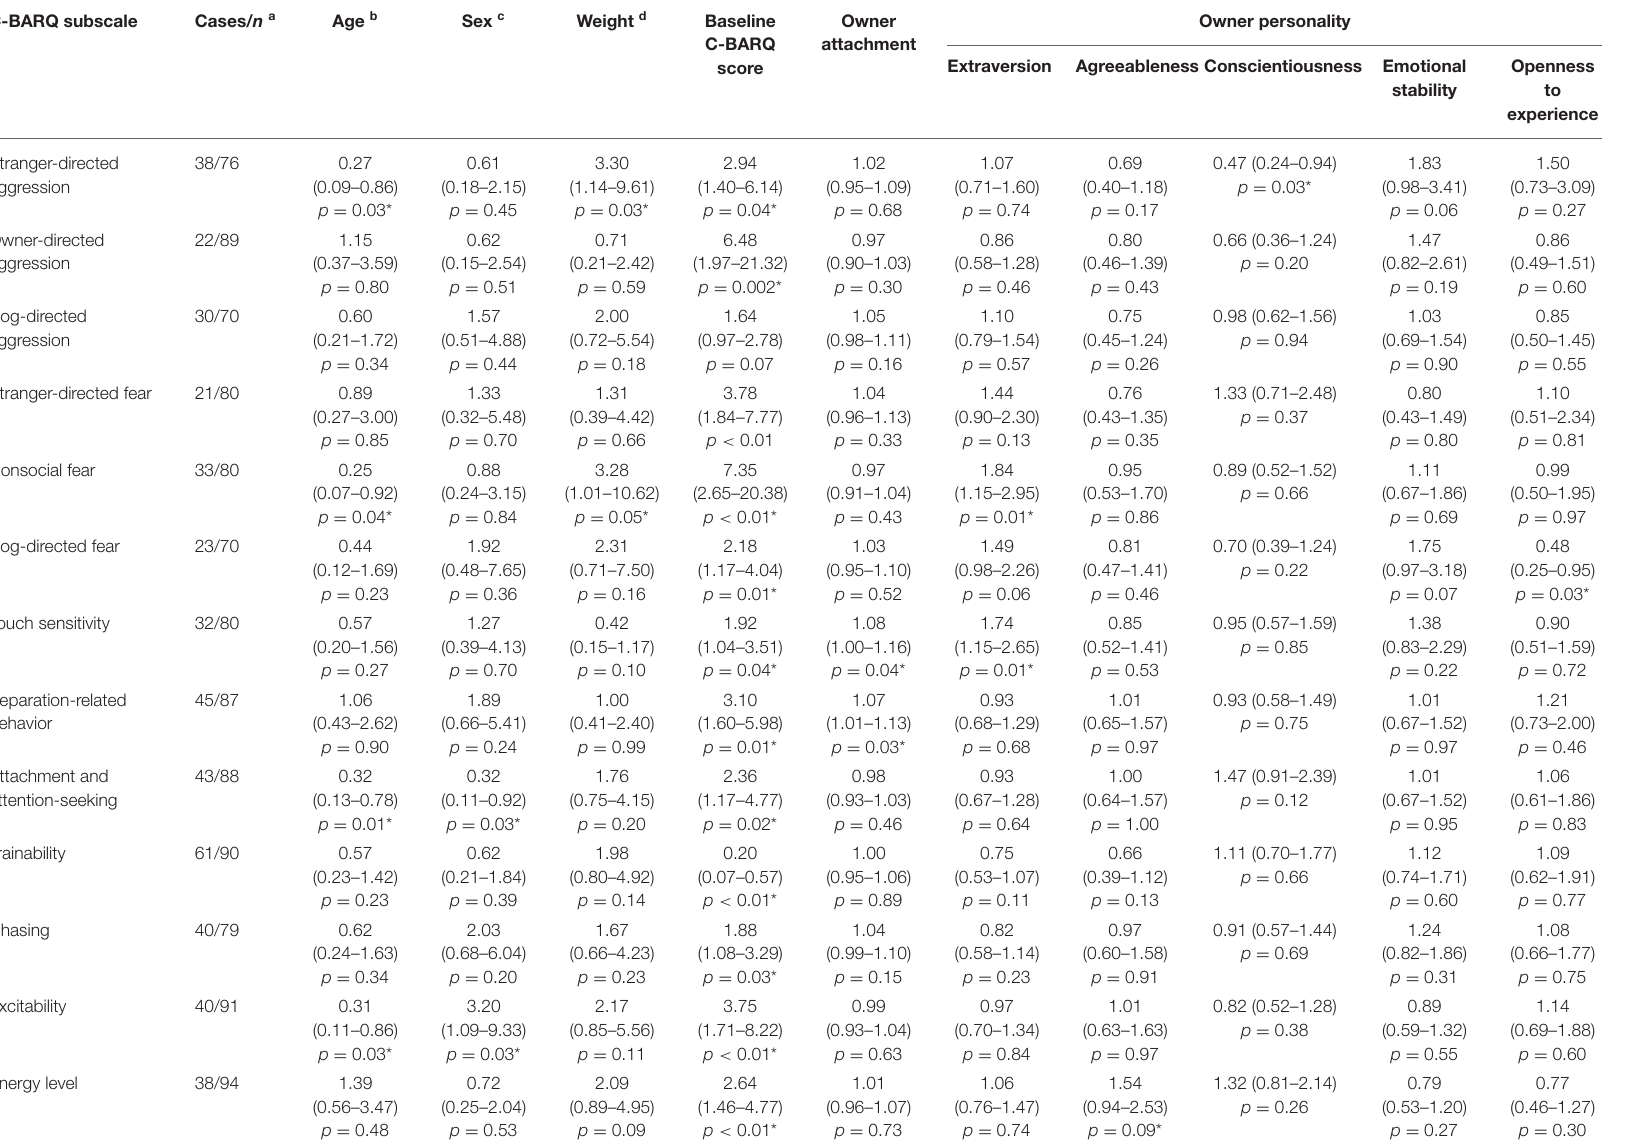
TABLE 4 | Logistic regression describing the associations between positive treatment outcomes at 3-months and owner and canine